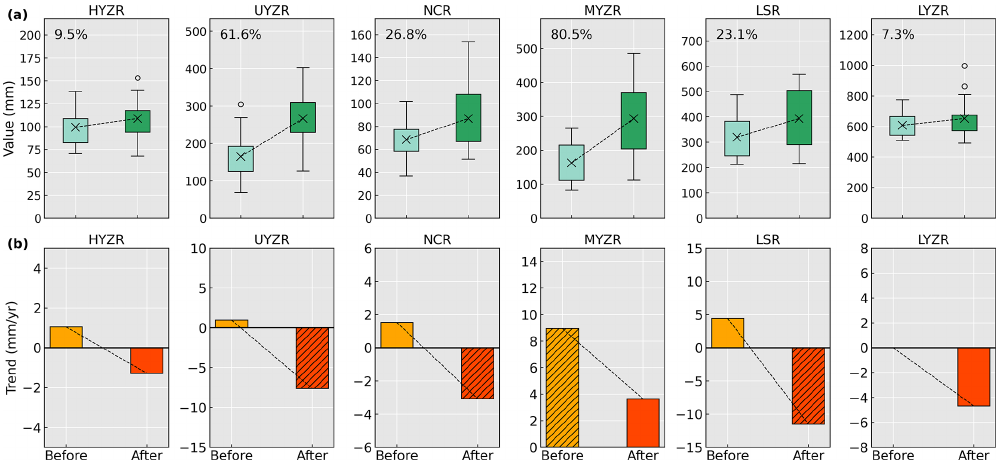
Figure 4. Water yield regime shifts in the entire UBR basin. (a) Magnitude of water yield changes. The black cross (x) shows the mean of the water yield, and the relative change is labeled in number (%) in each box plot. (b) Direction of water yield changes. The black hatching represents the statistically significant trend ( p < 0 . 05). The color of the boxes represents the period before (light color) and after (dark color) the Tp